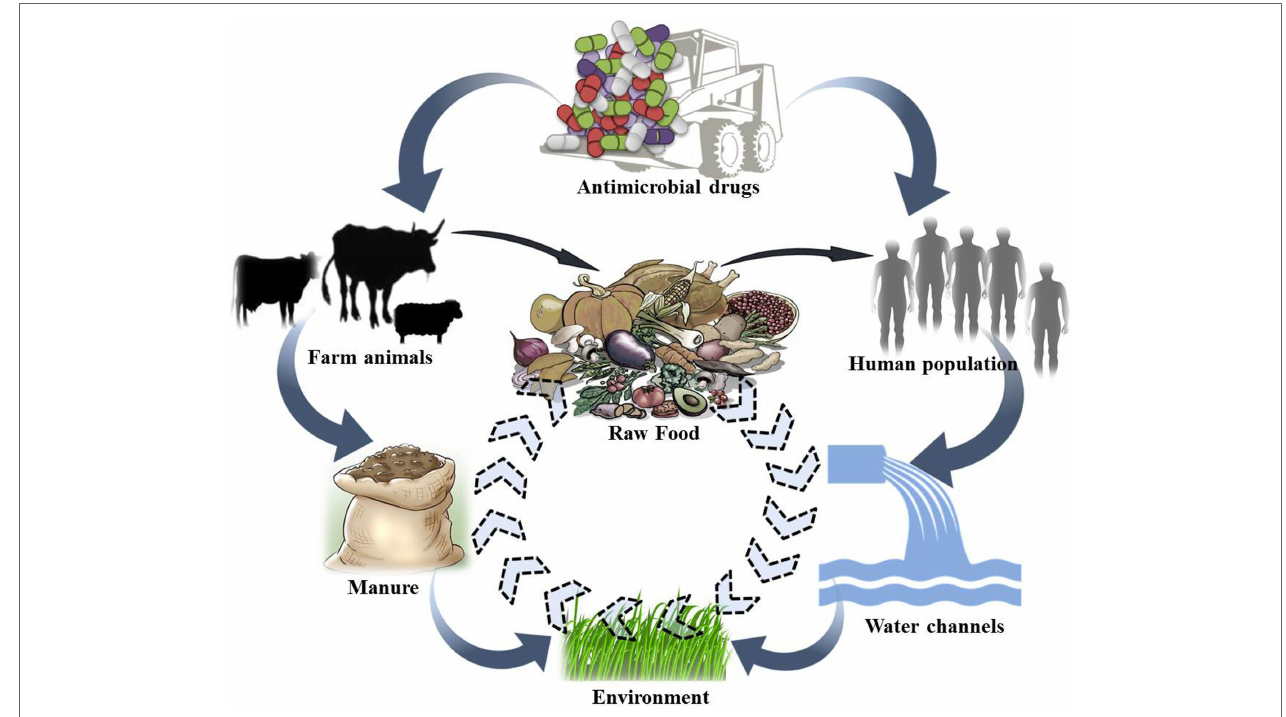
FiGURe 2 | Conceptual representation of possible movement of antibiotic-resistant bacterial strains/genes between different